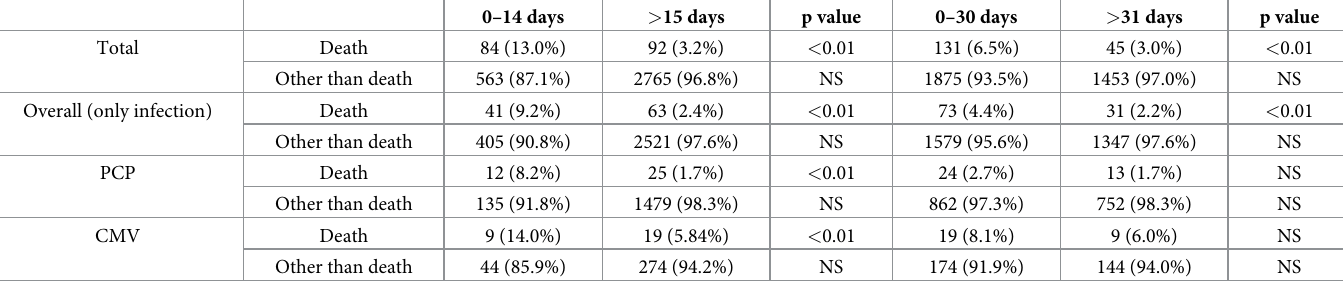
Table 1. Relationship between time to ART introduction and outcomes